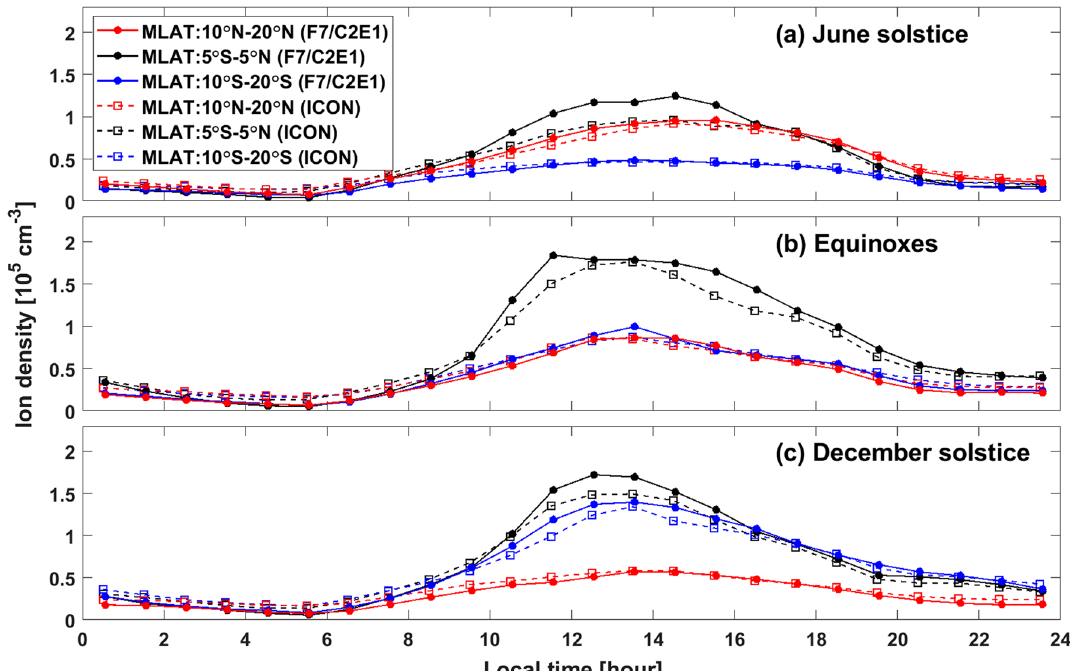
Fig. 4 Comparison of the averages of the observed ion densities by F7/C2E1 (blue) and ICON (black) at various magnetic latitude ranges for June solstice, Equinoxes, and December